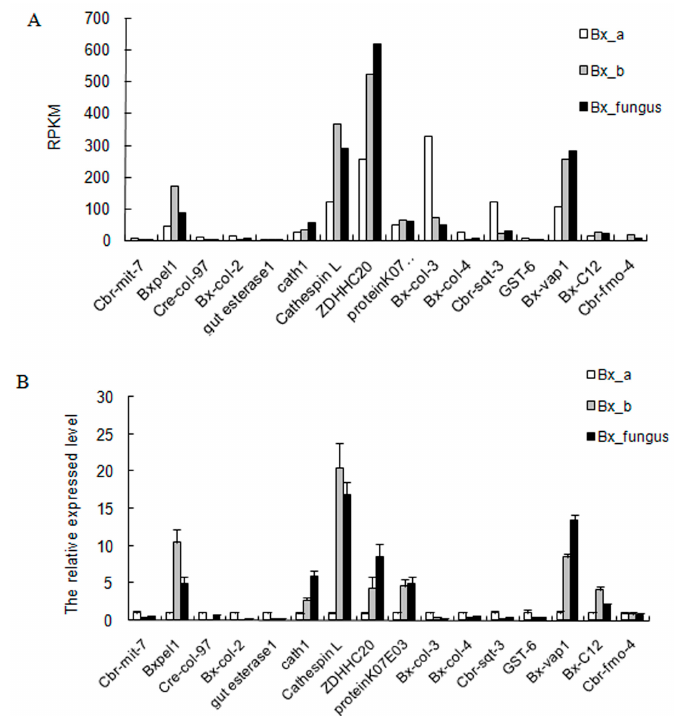
Figure 6. Relative gene expression. ( A ) Expression levels of 16 genes in sequencing results. RPKM, reads per kilobase per million reads; ( B ) qRT-PCR results of 16 differentially expressed genes under sterile, endobacterium treatment, and fungus conditions. White bars indicate expression levels of the genes in control samples (Bx_a); gray bars indicate expression levels of genes in endobacterium-treated PWN samples (Bx_b); black bars indicate expression levels of genes in fungus PWN samples (Bx_fungus). Data represent the means ± SD ( n = 3). SD, standard deviations.